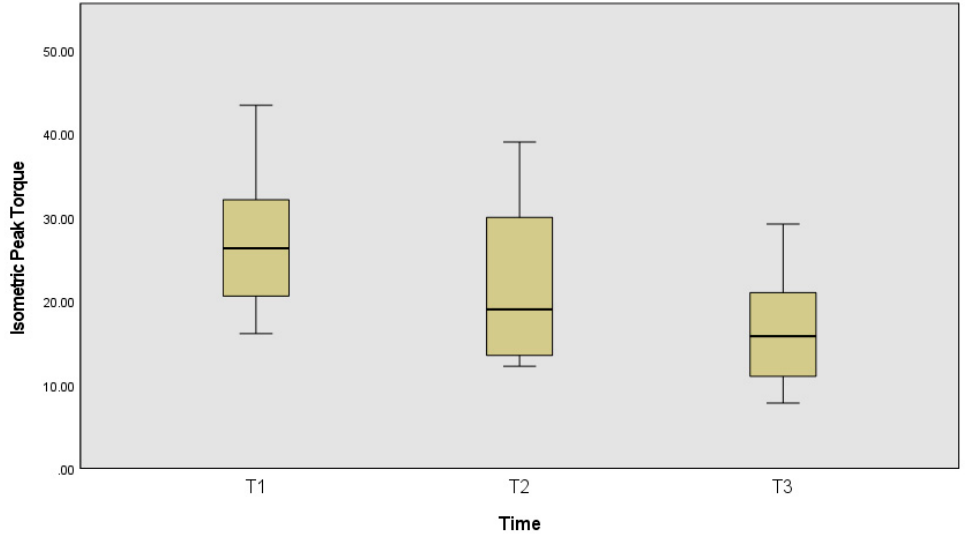
Figure 4. Isometric peak torque, in N.m, at the beginning of the measurement protocol (T1), in the middle (T2) and during the reported fatigue (T3).